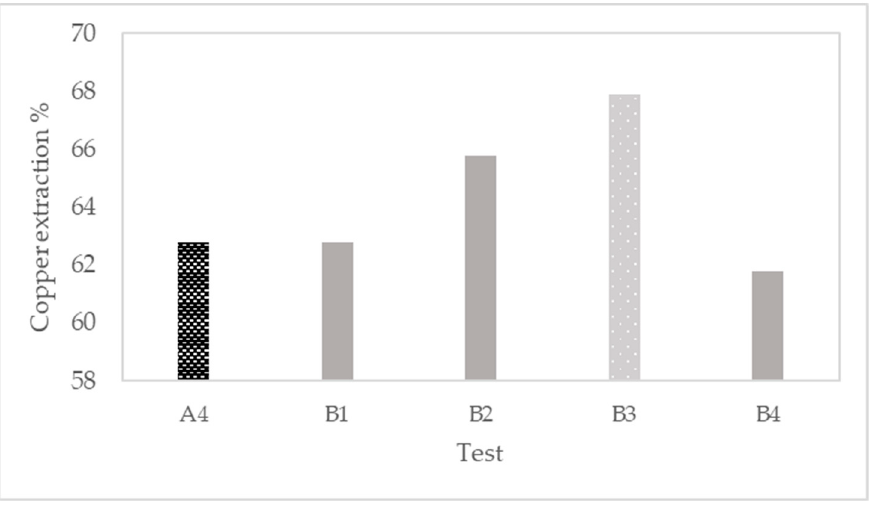
Figure 3. Effect of variables sulfuric acid, sodium chloride, and pretreatment time on pretreatment stage (test A).